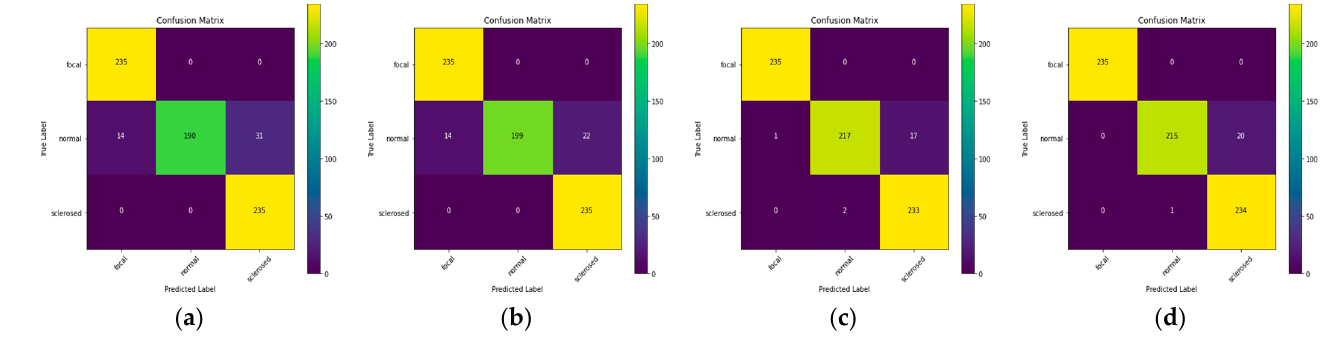
Table 4. Classification of the allied model. Evaluation Classify Classify Precision Recall F1-Score Focal Sclerosed VGG16 and VGG19 combined into the combination model produce better results.